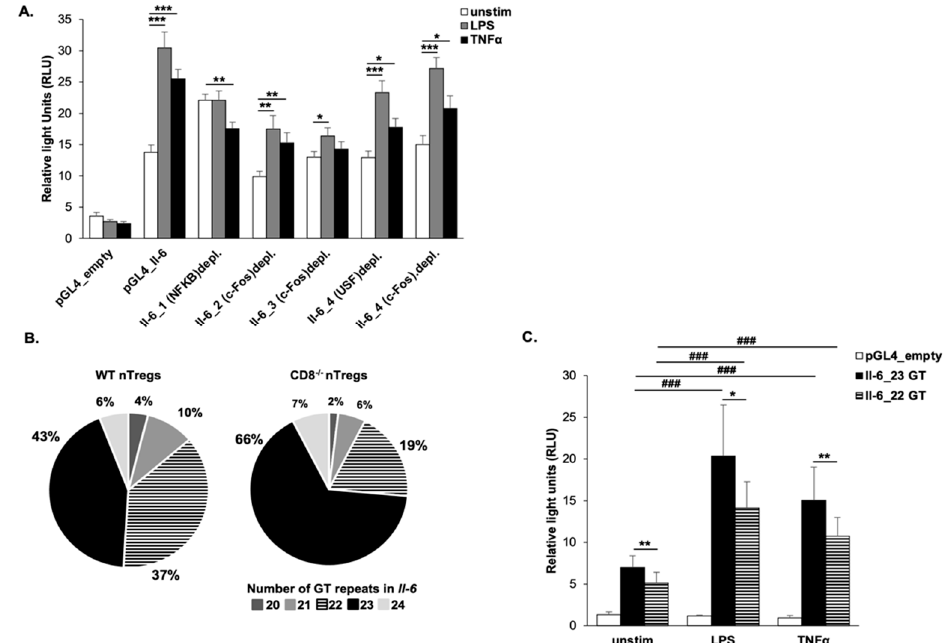
Figure 2. Transcription factor binding sites of NF- κ B, c-Fos, and members of the SP and USF family as well as a novel GT repeat affect Il-6 promoter activity. ( A ) NIH3T3 cells were transiently transfected with the empty pGL4 luciferase vector (pGL4 empty) or with different reporter constructs of the Il-6 promoter (1138 bp). In the construct Il-6_1 (NF- κ B)depl., the NF- κ B binding site as identified by EMSA within Il-6_1 was depleted by site-directed mutagenesis. Correspondingly, the c-Fos binding site within Il-6_2 (Il-6_2(c-Fos)depl.), the c-Fos binding site within Il-6_3 (Il-6_3(c-Fos)depl.), the USF binding site within Il-6_4 (Il-6_4(USF)depl.), and the c-Fos binding site within Il-6_4 (Il-6_4(c-Fos)depl.) were mutated